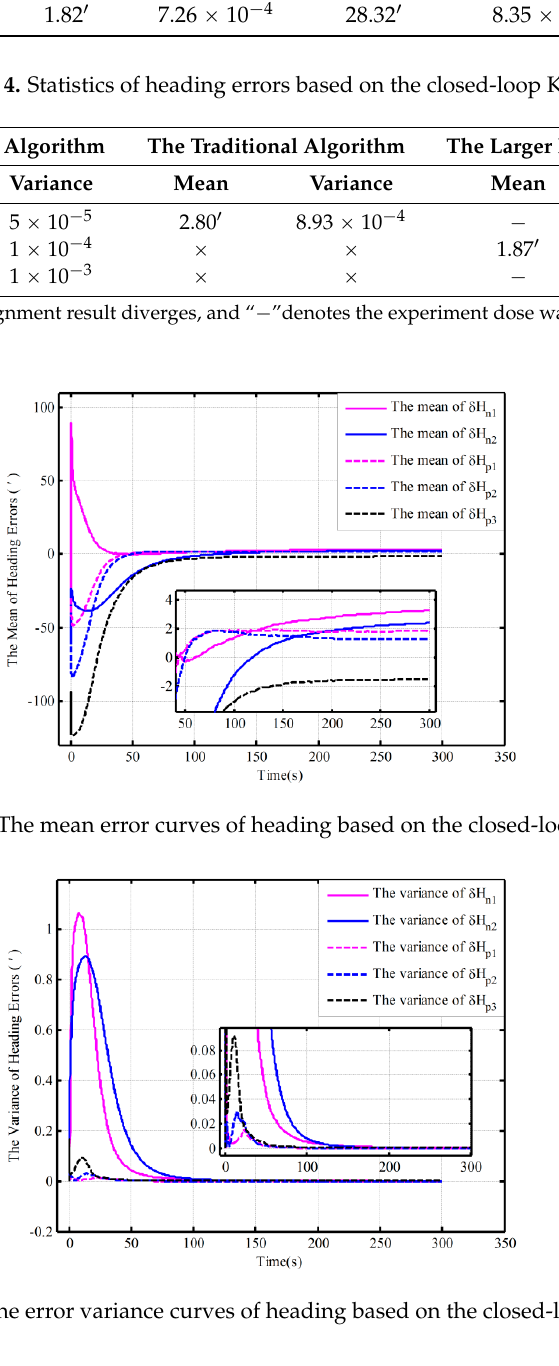
Figure 9. The IMU and turntable. The fine alignment experiments based on the proposed algorithm and the traditional one are done, which is assisted by the open-loop and closed-loop KFs, respectively. The initial conditions of the open-loop KF alignment are given in Table 1, and the closed-loop KF alignment initial conditions is described in Table 5. The alignment results (only heading error) based on the open-loop KF are shown in Figure 10. Figures 11 and 12 show the alignment results based on the closed-loop KF. Table 5. The different initial conditions for fine alignment. The Coarse Alignment Accuracy